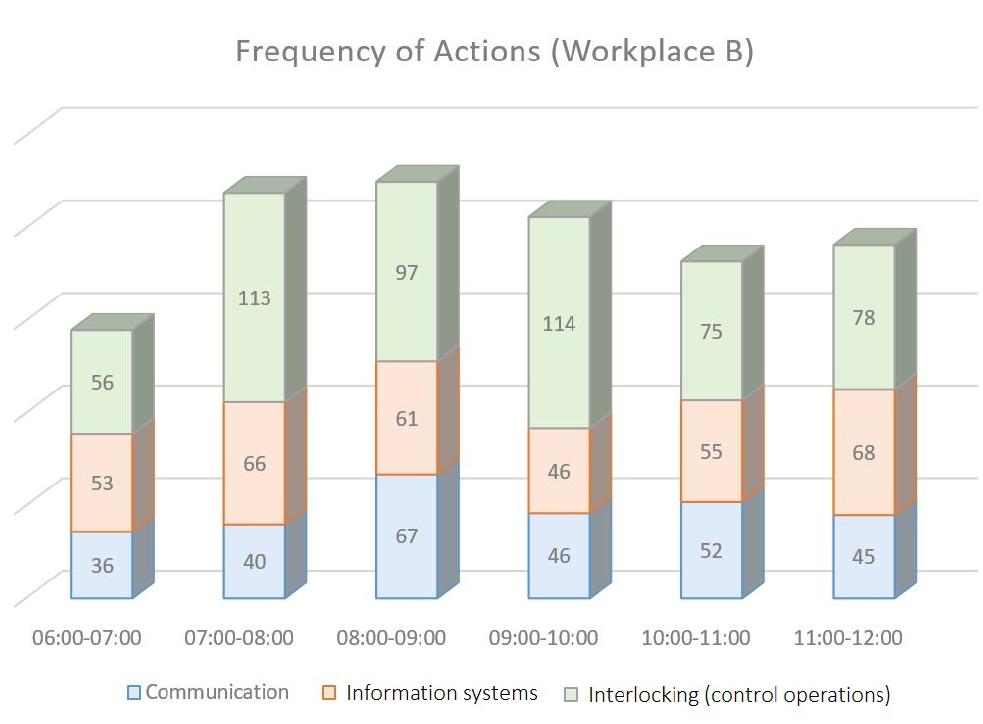
Figure 4. Frequency of actions distributed over time intervals at workplace B (period 06:00–12:00).